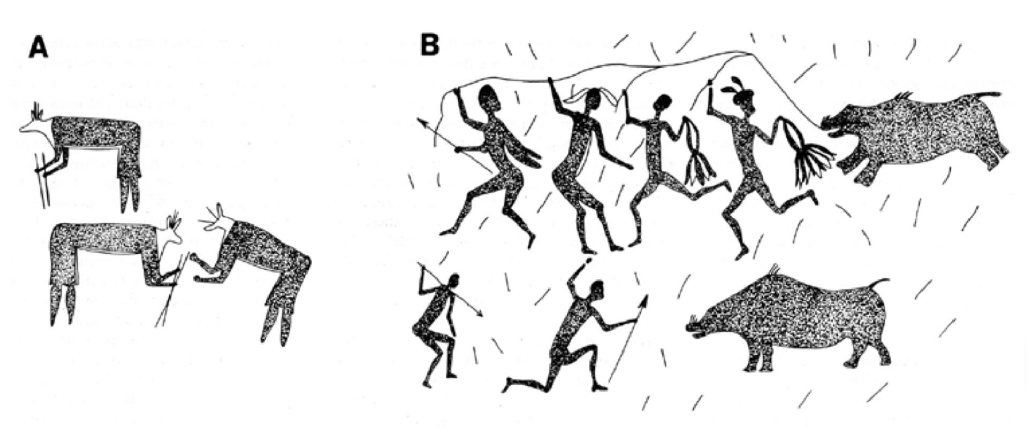
Figure 1. Orpen’s 1874 copies of the rock art at Melikane ( a ) and “Mangolong” ( b ) (Sehonghong River, Lesotho): ( a ) shows “rhebok men” who could tame “eland and snakes”; and ( b ) “submerged” men and women capturing a “rain animal” that is also a snake. Adapted from [9], p. 19, after [10], p. 430, and [11], p.